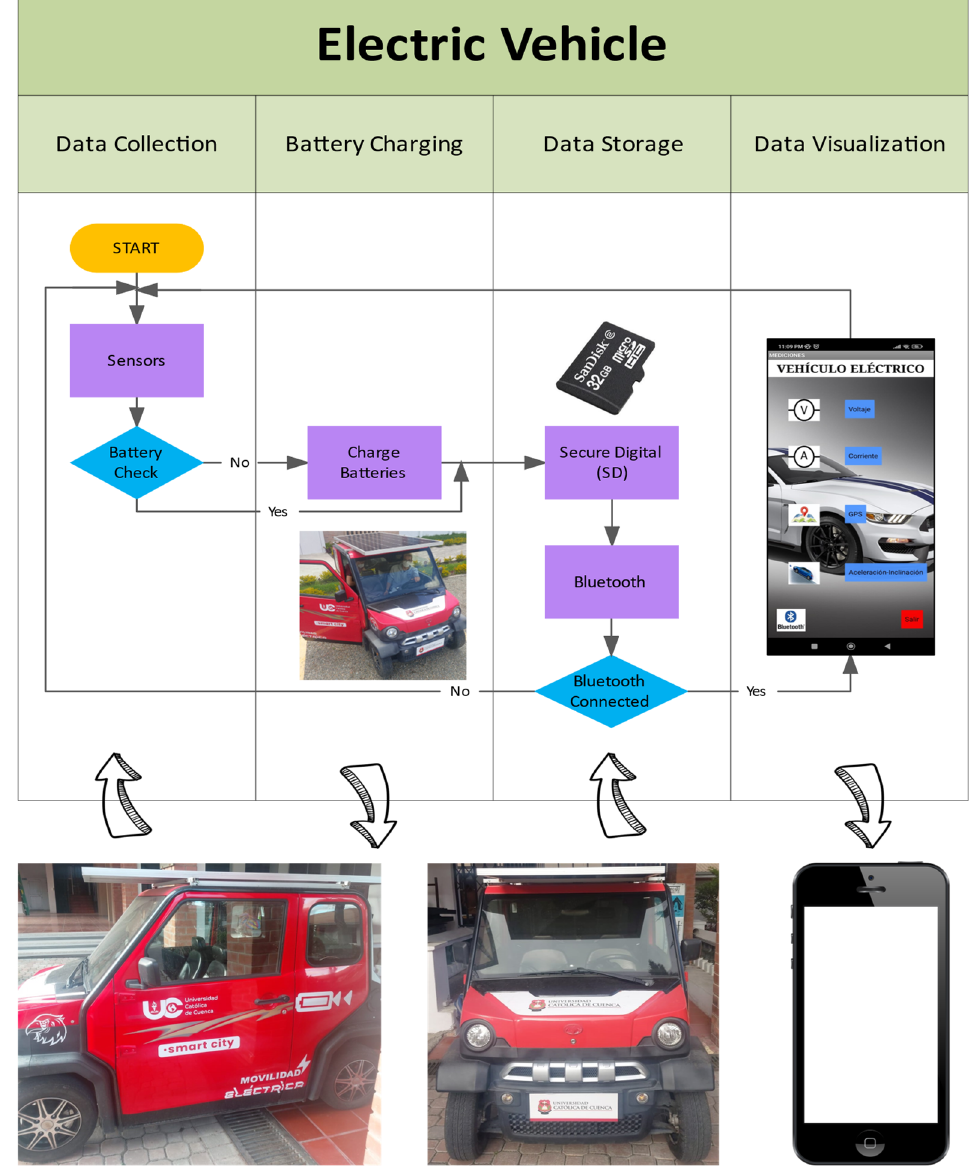
Figure 2. Flow diagram showing the basic operation of the system (hardware and software).